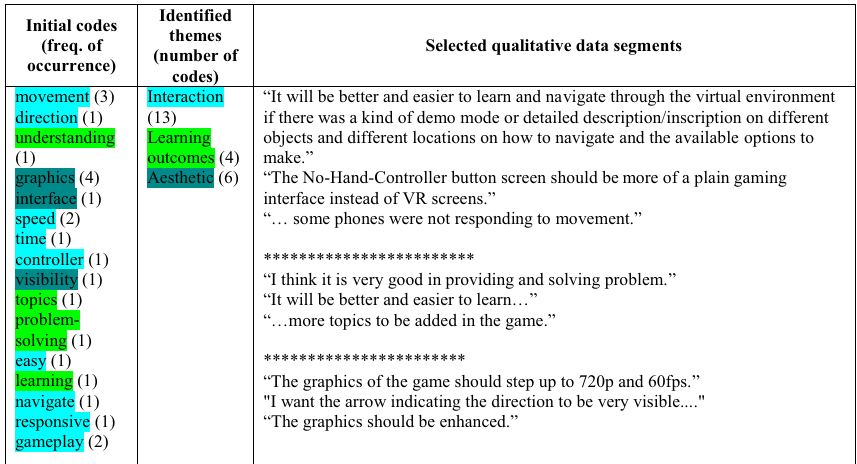
T-ratios greater than 1.65 (in absolute value) suggest that the coefficient is statistically significantly different from 0 at the 95% confidence level